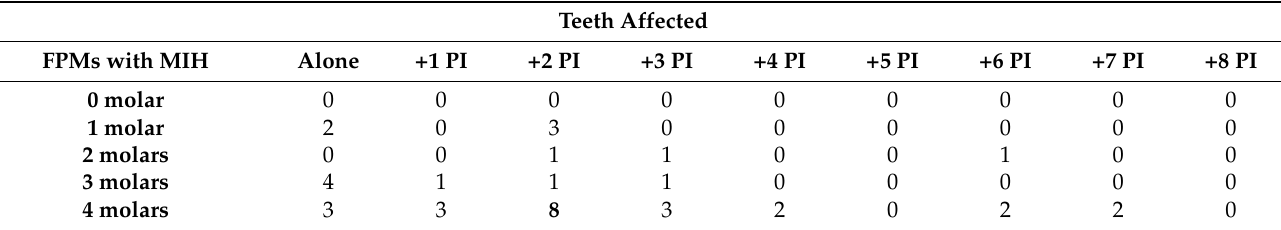
Table 6. The distribution of affected teeth in a group of Silesian children with MIH. Teeth